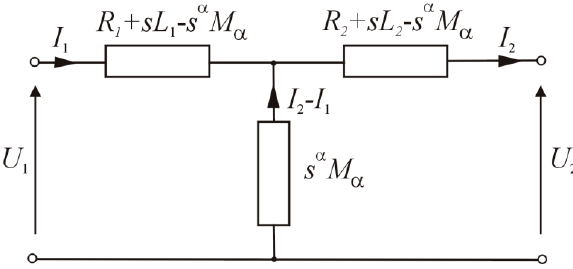
Figure 9. Circuit with magnetic coupling eliminated.